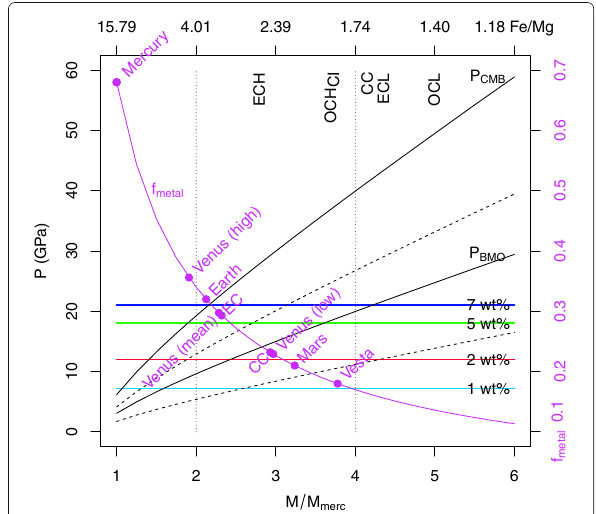
Fig. 4 Pressure at CMB ( P CMB ) and at base of liquid silicate ( P BMO ) for Mercury grown by addition of silicate to its mantle. Four lines show the range of minimum feasible pressures based on metal-silicate equilibrium at Mercury (cid:6) IW = − 5.4 (Namur et al. 2016). Vertical dashed lines show range of proto-Mercury sizes suggested by planetary metal and Fe/Mg (Fig. 3). Top axis shows Fe/Mg mass ratio for the added amounts of silicate and Fe/Mg ratios for classes of chondritic meteorites (carbonaceous, enstatite, OC ordinary, and L or H for low and high iron groups (McDonough and Sun 1995)). Dashed lines around P BMO curve show a range of pressures used in different magma ocean models, 2 / 7 ≤ P BMO / P CMB ≤ 2 / 3 (Tuff et al. 2011; Rubie et al. 2011). f metal curve (right axis) shows mass fraction of core when silicate is added to Mercury’s mantle. Labels on f metal curve indicate metal fraction of carbonaceous chondrites (McDonough and Sun 1995), enstatite chondrites (Javoy et al. 2010), Venus (Dumoulin et al. 2017), Earth (Stacey 1992), Mars (Rivoldini et al. 2011) and Vesta (Russell et al. 2012) for